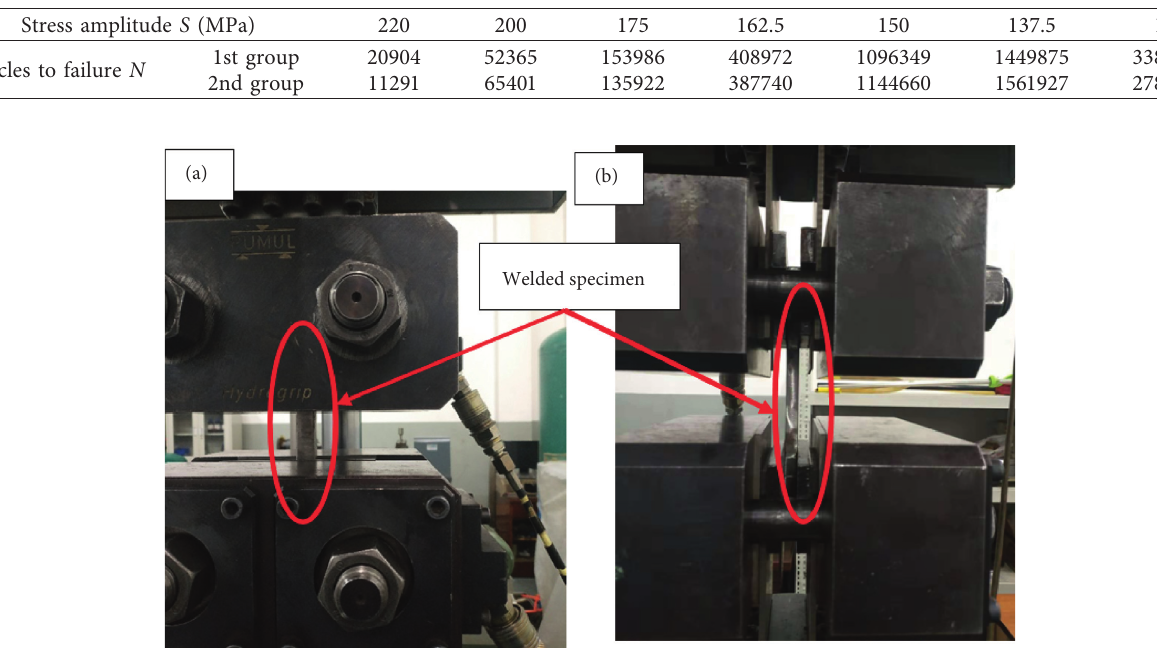
Figure 16: The installation of the welded specimens. (a) Front face; (b) side